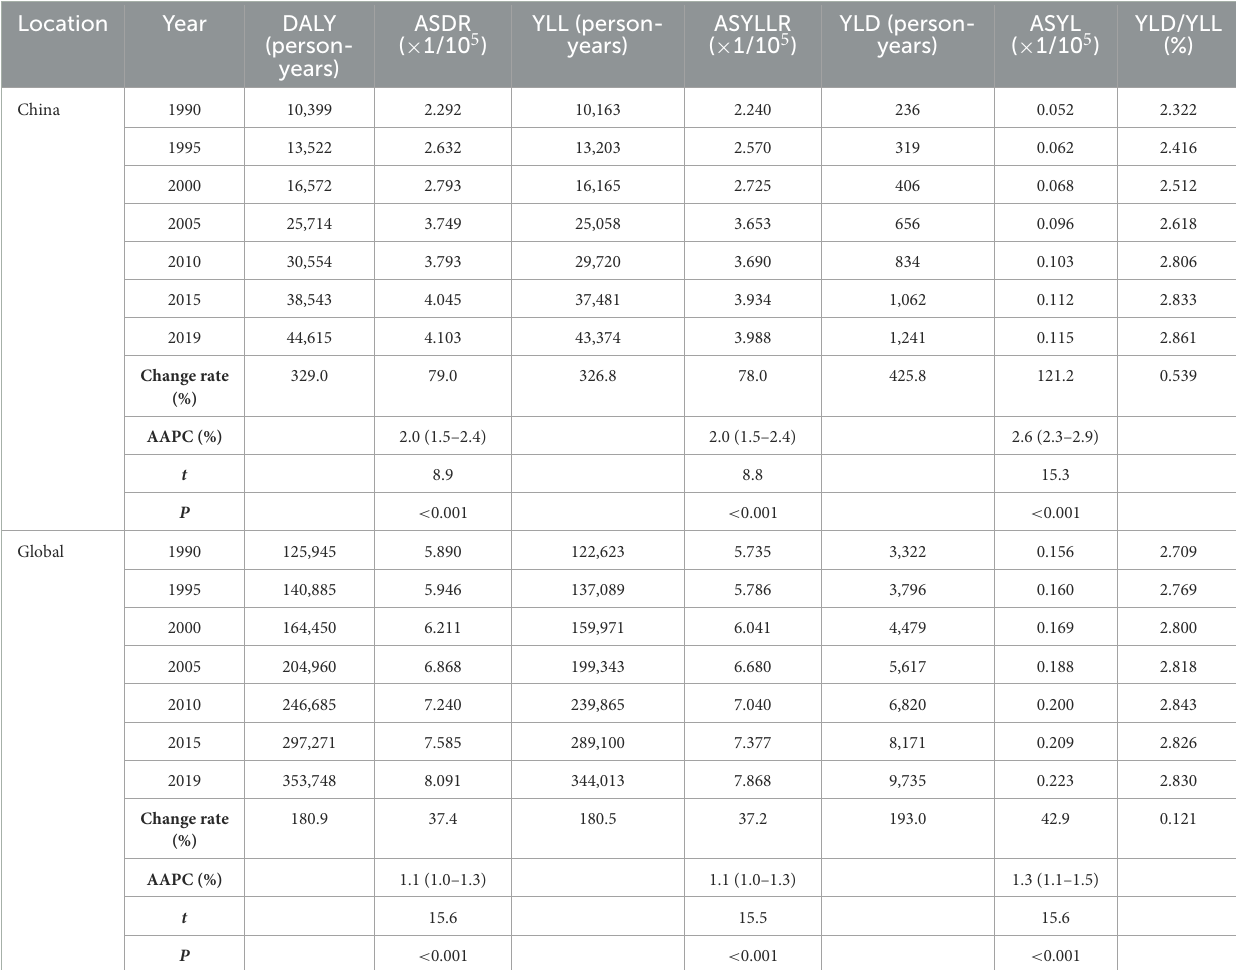
TABLE 2 Disease burden of ovarian cancer attributable to hyperglycemia from 1990 to 2019. Location